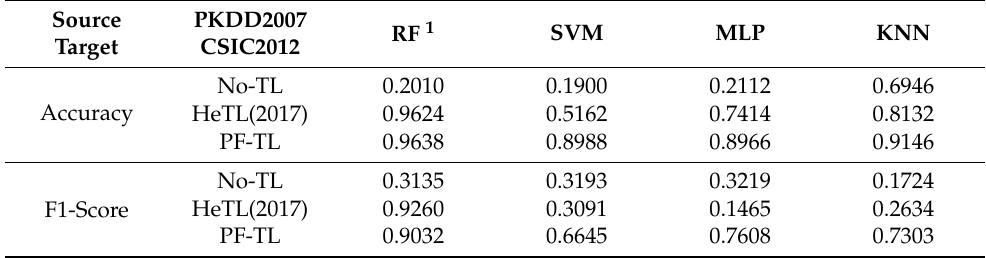
Table 12. Algorithm comparison of transfer learning on Scenario 2.